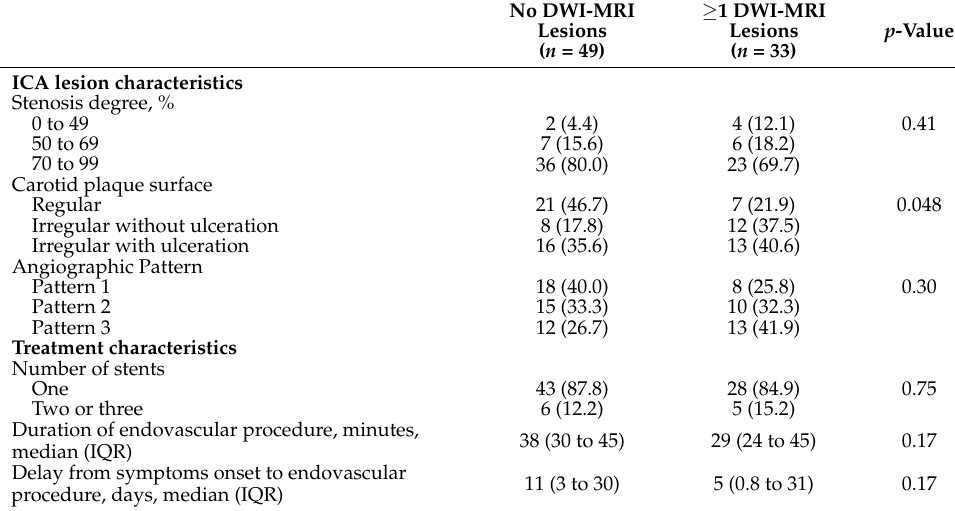
Table 3. Comparisons of ICA lesion and treatment characteristics between patients with and without new cerebral lesions detected by